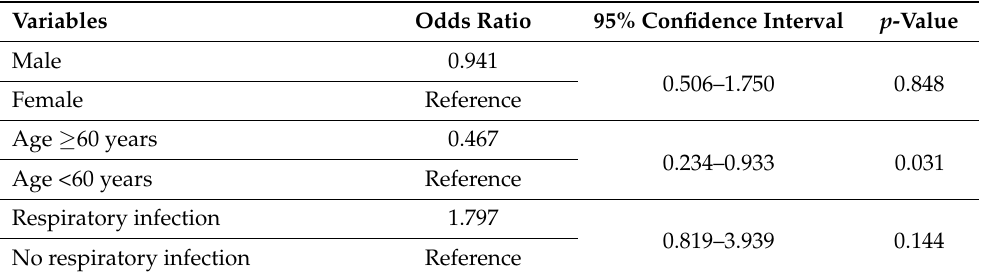
Table 4. Bivariate analysis of the association between variables and DIC development in septic